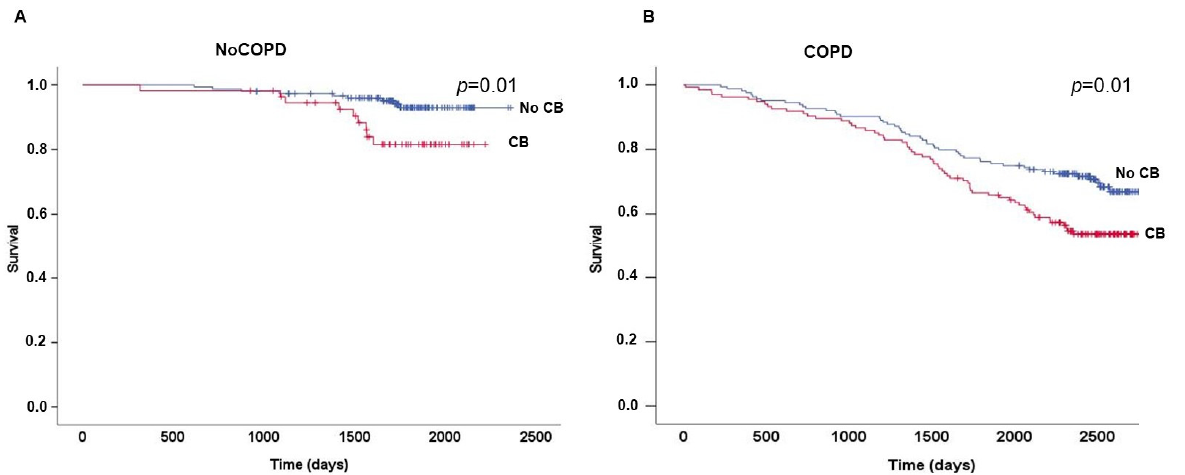
Figure 4. (A,B) Effects of Chronic Bronchitis (CB) on survival. Kaplan – Meier plots showing that the presence of CB decreases survival in ( A ) smokers without COPD ( p = 0.01) and in ( B ) those with COPD ( p = 0.01). COPD: Chronic Obstructive Pulmonary Disease.